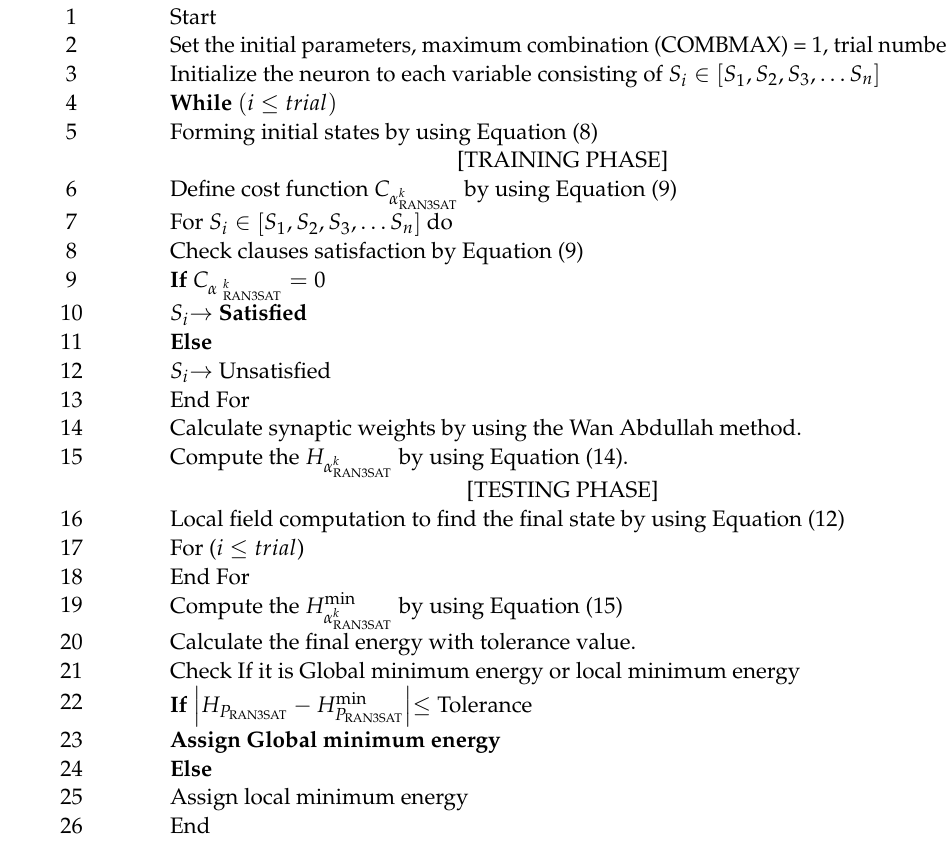
Algorithm 1 The pseudocode of DHNN-RAN k SAT in the logic